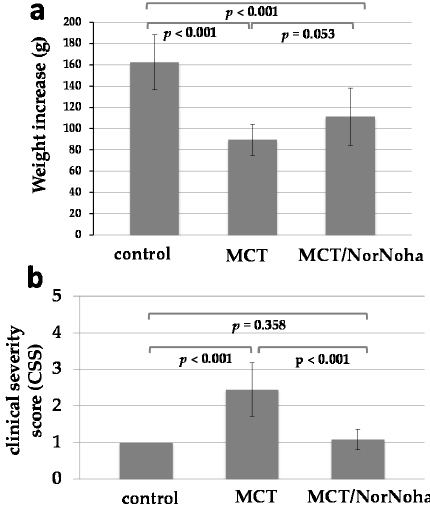
Figure 1. Graphical presentation of body weight increase ( a ) and clinical severity score ( b ) in the three experimental groups: control = sham-treated animals ( n = 11); MCT = monocrotaline induced PH ( n = 11); MCT/nor-NOHA = monocrotaline induced PH treated with nor-NOHA ( n = 13). Data are presented as means and standard deviation (SD).